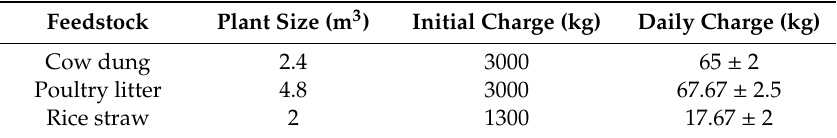
Table 3. Initial and daily feed stock charges used in three farm scale anaerobic digestion (AD)